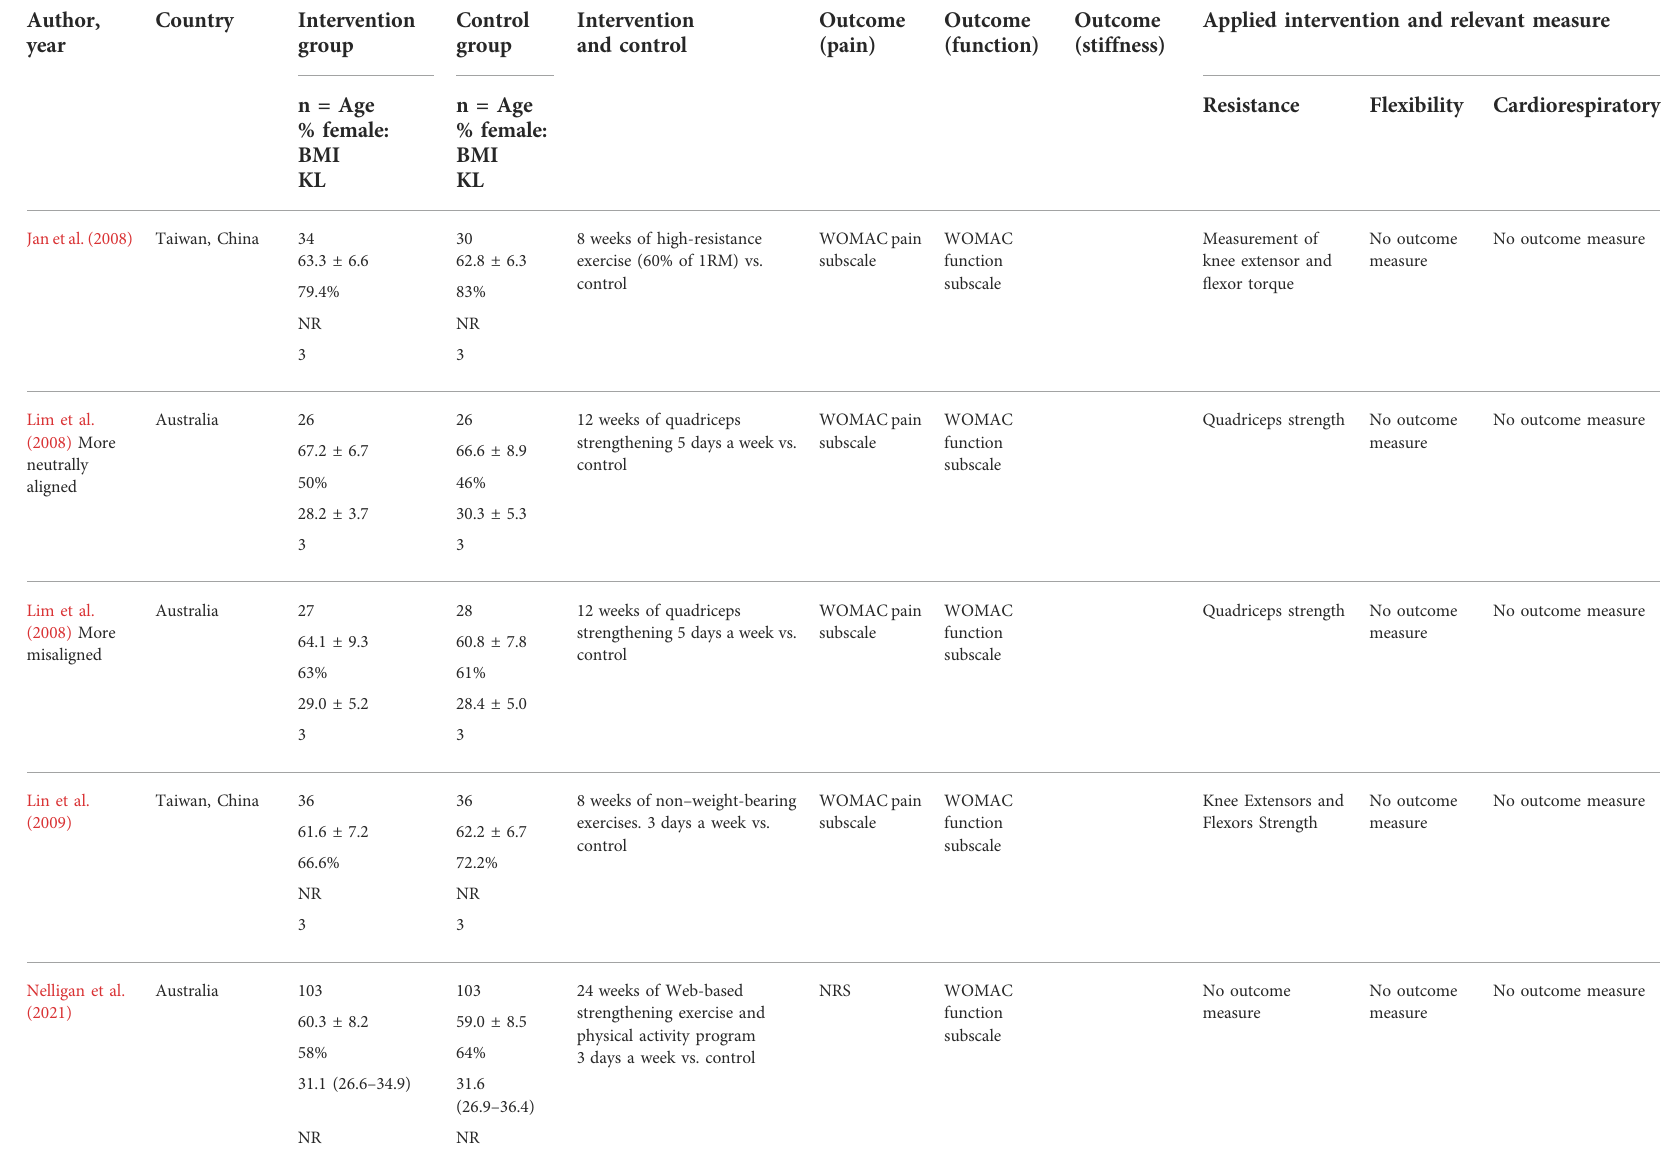
TABLE 4 ( Continued ) Exercise interventions evaluated according to the American College of Sports Medicine ’ s (ACSM)